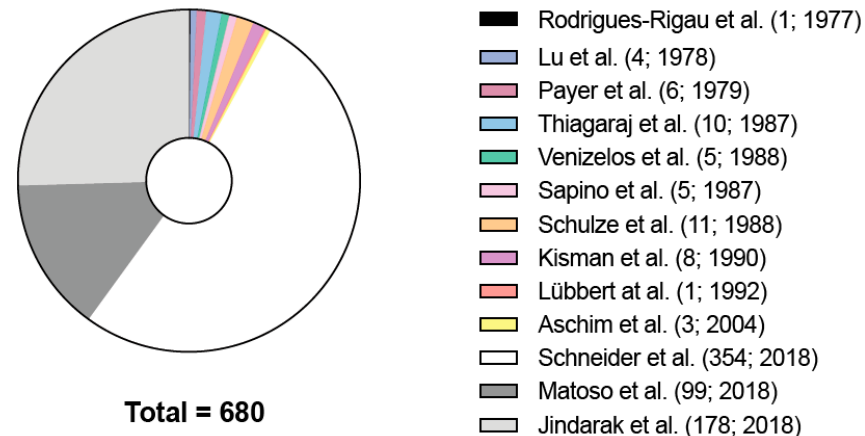
Figure 1. Studies on testicular histology of transgender patients. The 13 publications that analyzed testicular histology ( n = 680) of transgender patients. In brackets are the total numbers of